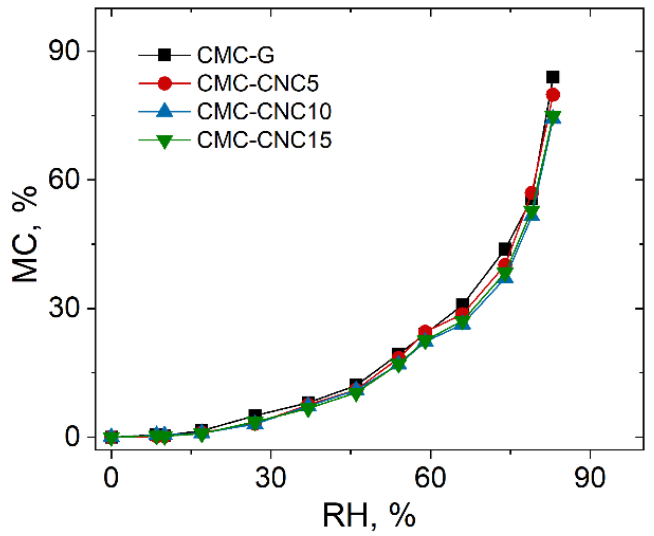
Figure 9. Sorption isotherms for the studied samples